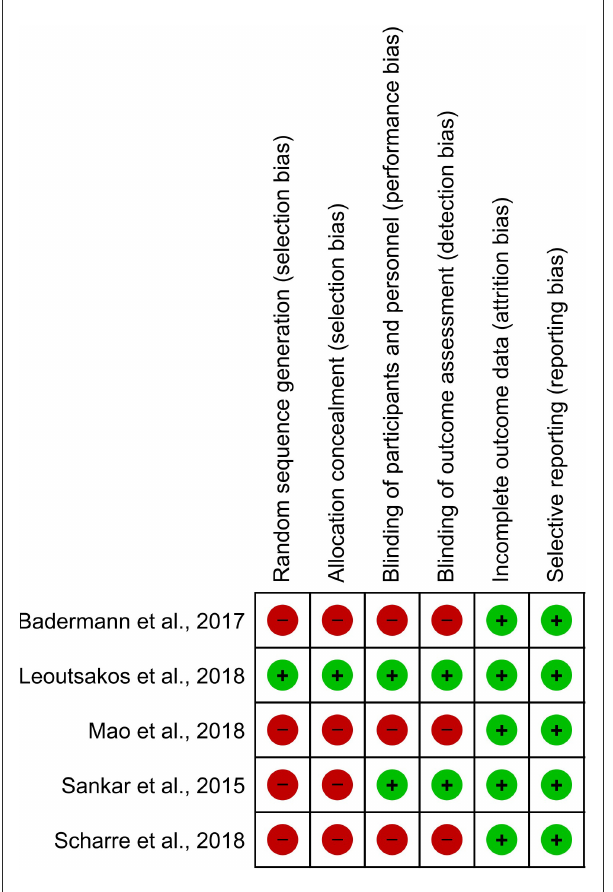
FIGURE4 Different levels of risk of bias for each item in included studies. The Cochrane risk of bias tool was used for the detection of publication bias. In this color-coded ranking, the green color represents a low risk of bias and red high risk of